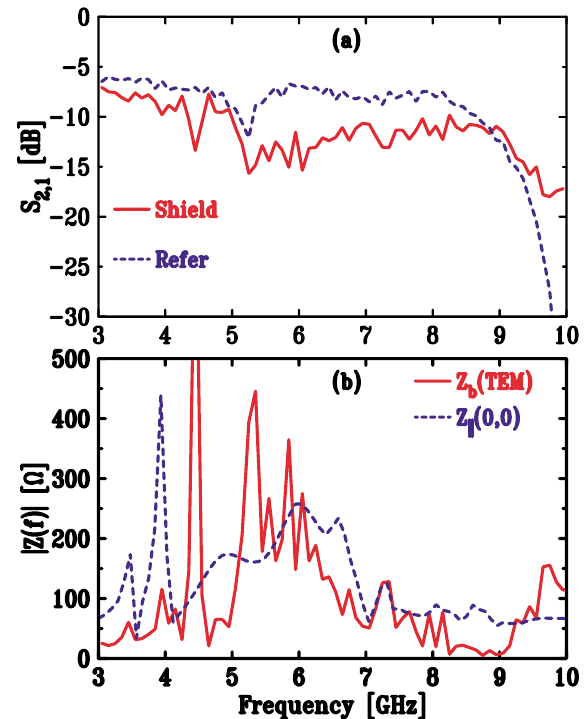
FIG. 13. (Color) (a) Measured S for the TEM drive of the 2 ; 1 bellows shield and the reference section versus frequency and (b) the estimated beam impedance of the shield and the longitudinal impedance calculated by GDFIDL , Z k (cid:8) 0 ; 0 (cid:9)